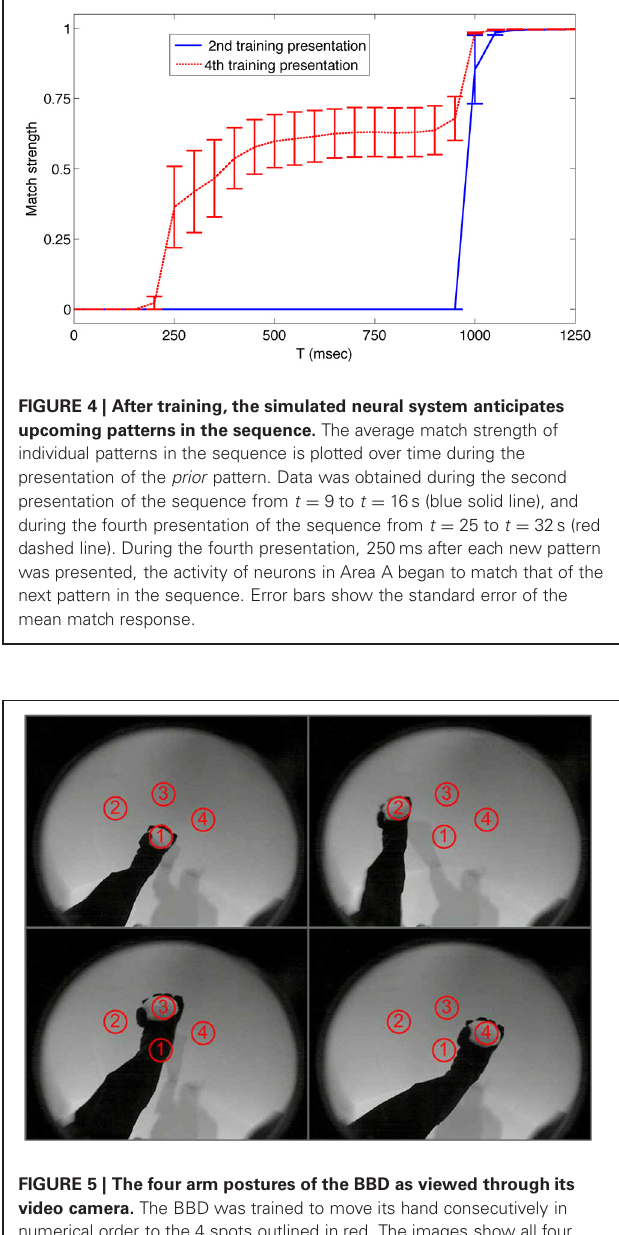
A to Area B essentially create a copy of Area A’s pattern of activity in Area